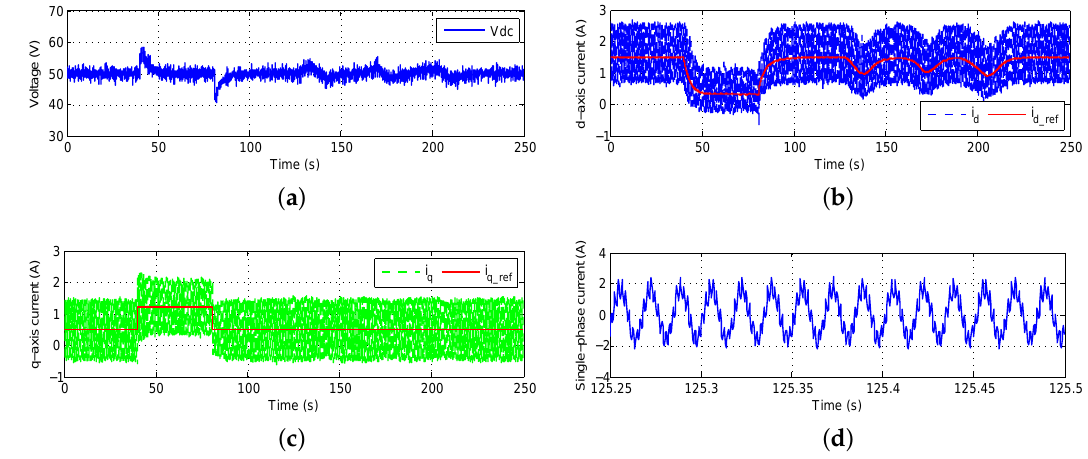
Figure 16. Conventional vector control for the AC/DC/DC converter with the L filter. ( a ) DC-link voltage; ( b ) point of common coupling (PCC) q -axis current waveform; ( c ) PCC q -axis current waveform; ( d ) single-phase current waveform.